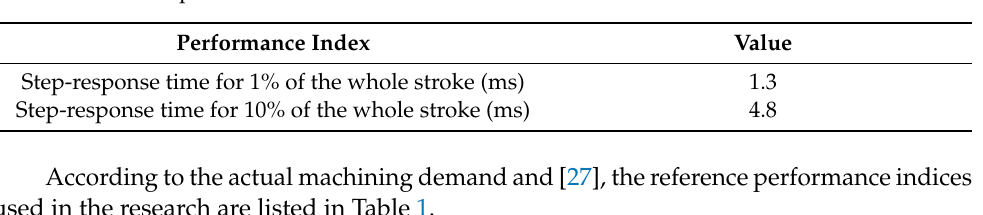
Table 1. Reference performance indices for the motor of the GS.